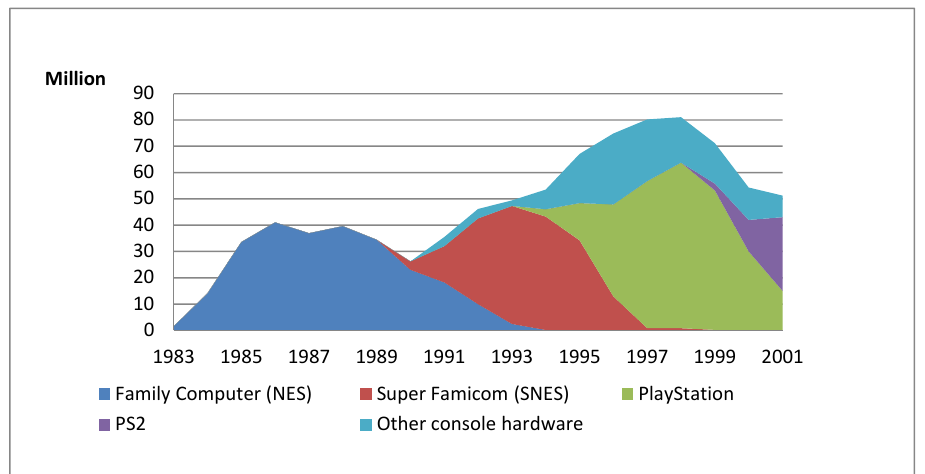
Figure 1. Growth of the Japanese console video game software market